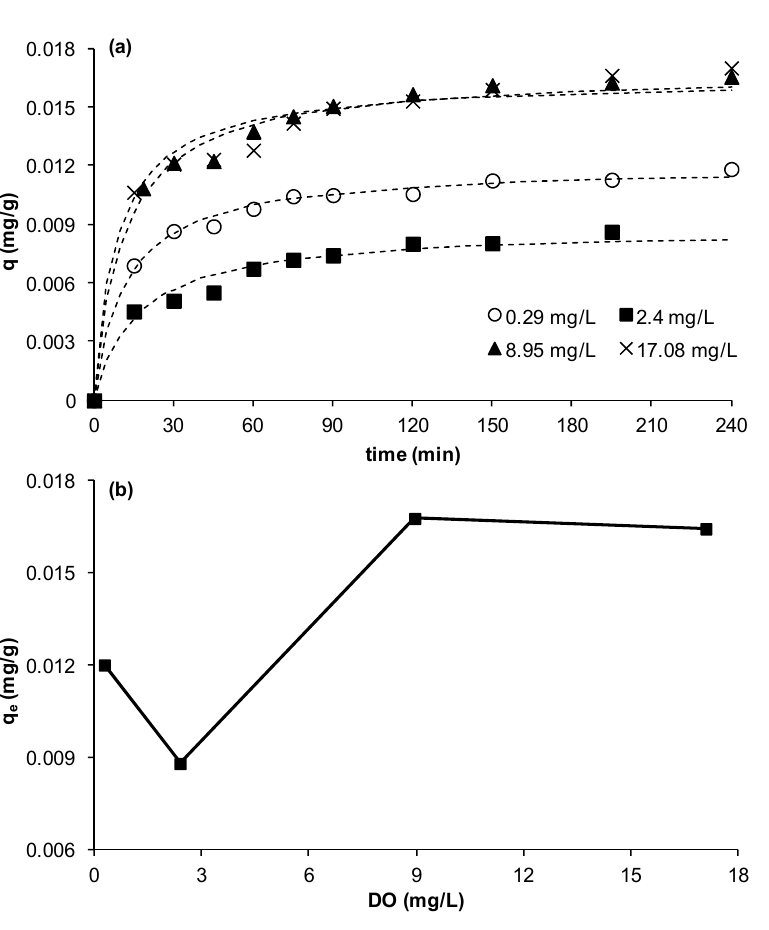
= 50 g, C = 23 sand 0